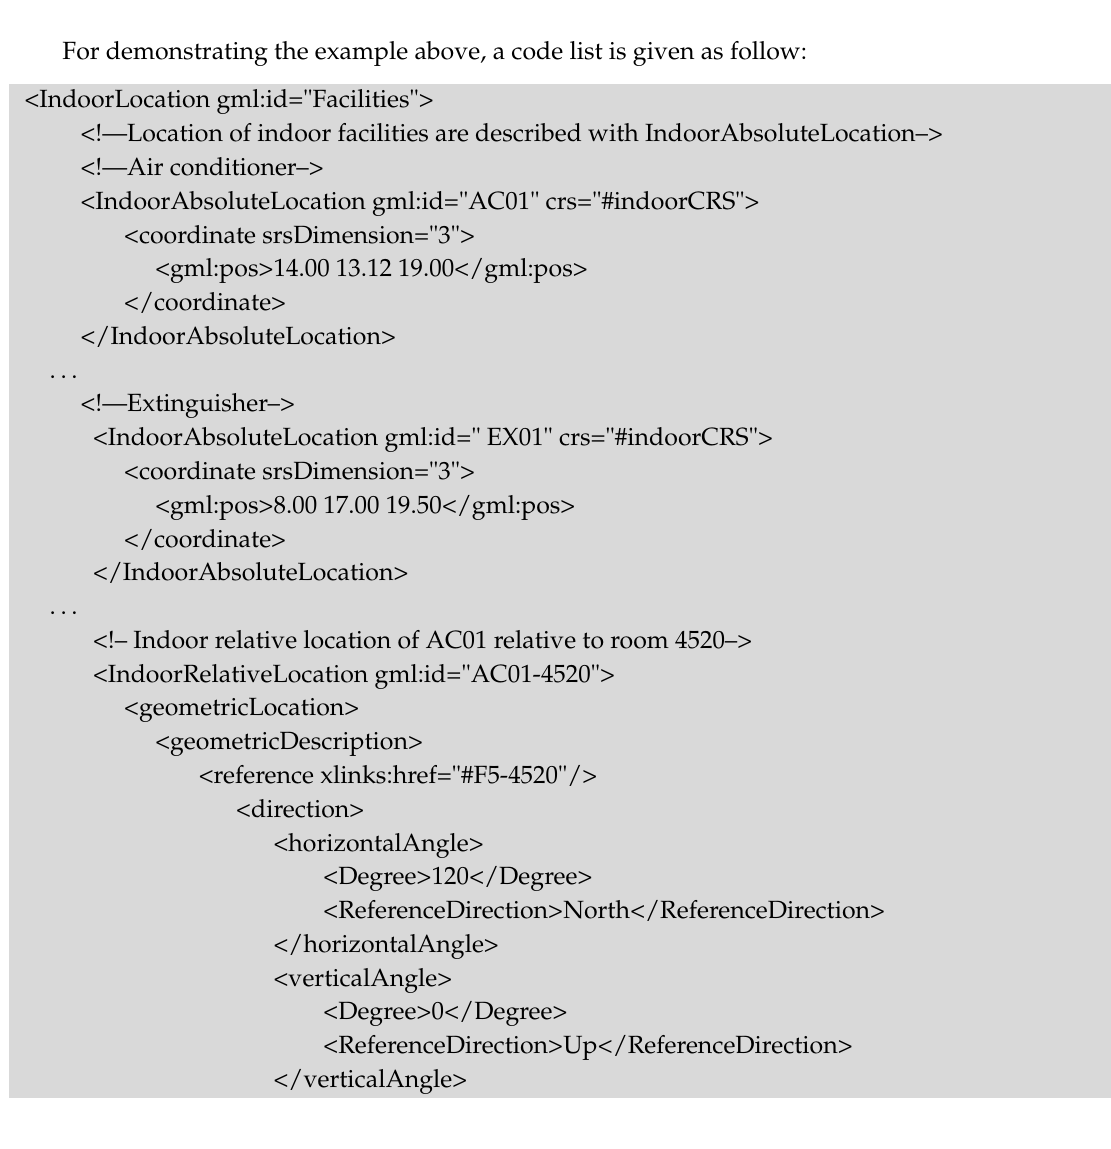
Figure 6. Indoor facilities management.